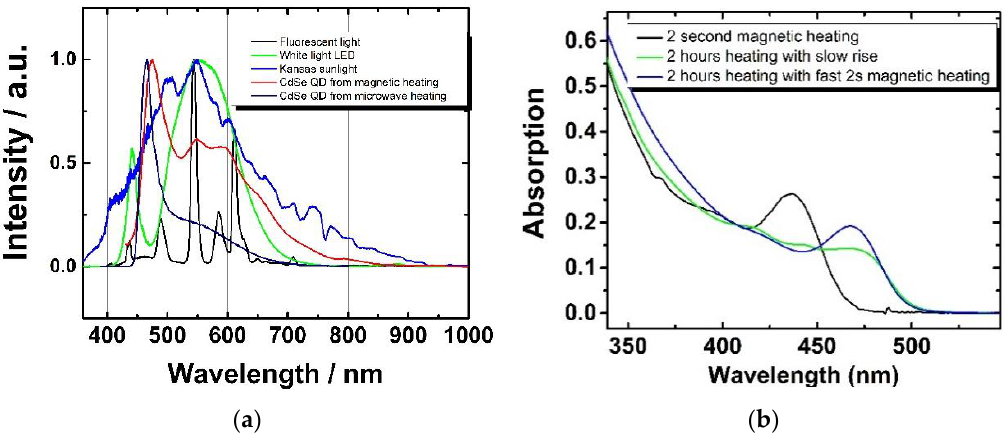
Figure 6. White light emission of ultrasmall quantum dots (QDs) produced in magnetic/microwave heating vs. other competing light sources ( a ). Absorption spectra of CdSe QDs synthesized when magnetic heating ( b ) is combined with traditional heating methods. The initial rapid magnetic heating provides a positive impact on the size distribution of the CdSe QDs.